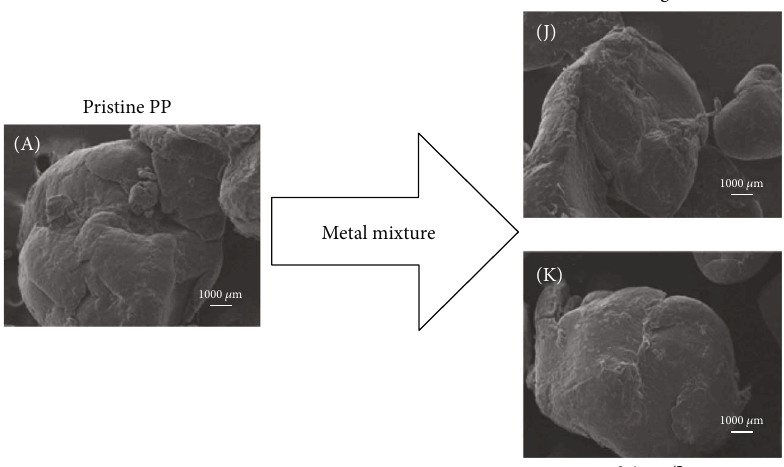
Figure 8: Scanning electron microscopy of polypropylene adsorption of various heavy metals ( V = 20 mL, temperature at 298K, t = 48